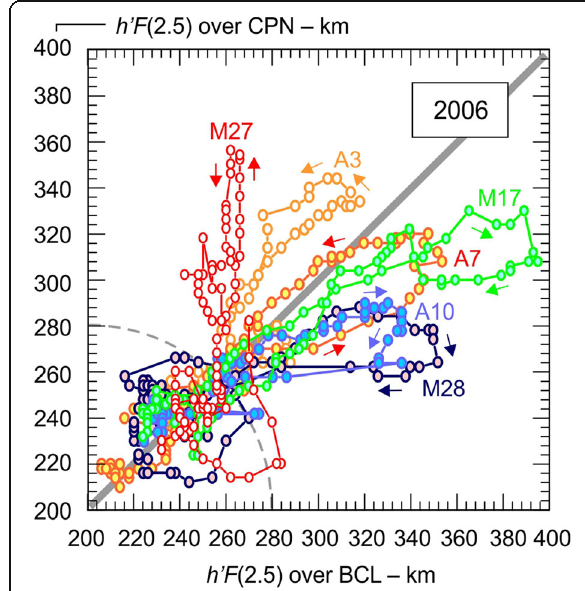
Fig. 7 Scatter plot of six strong ESF nights during March – April 2006, where h ’ F (2.5) values over CPN are plotted versus those over BCL, measured at the same UT